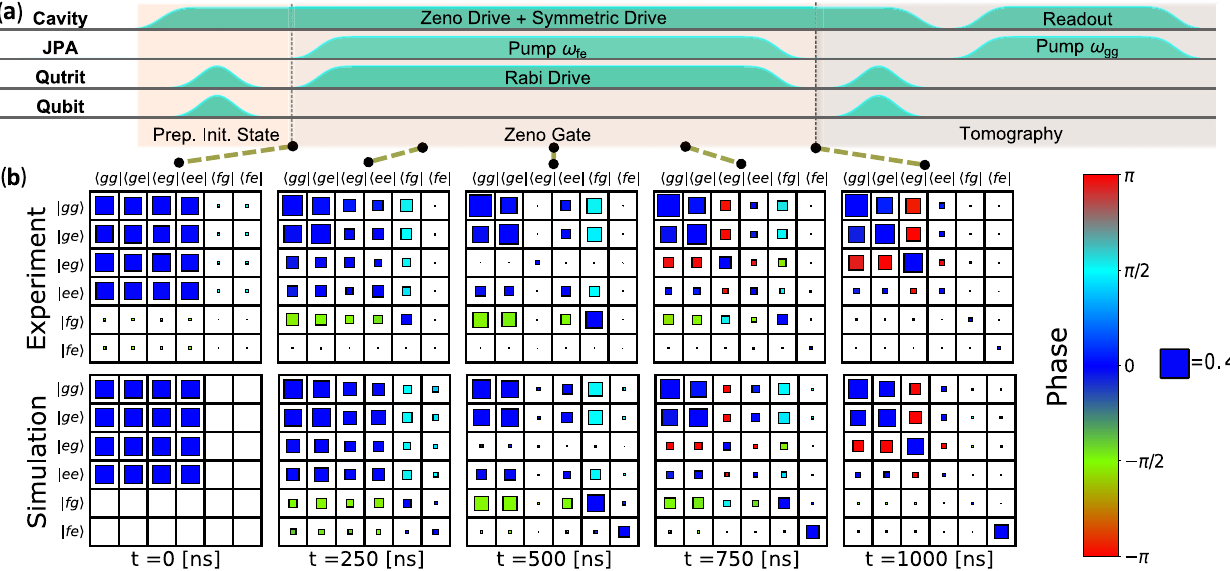
ffiffiffi p 2 . Black squares are partially fi lled to represent the amplitude, where a full